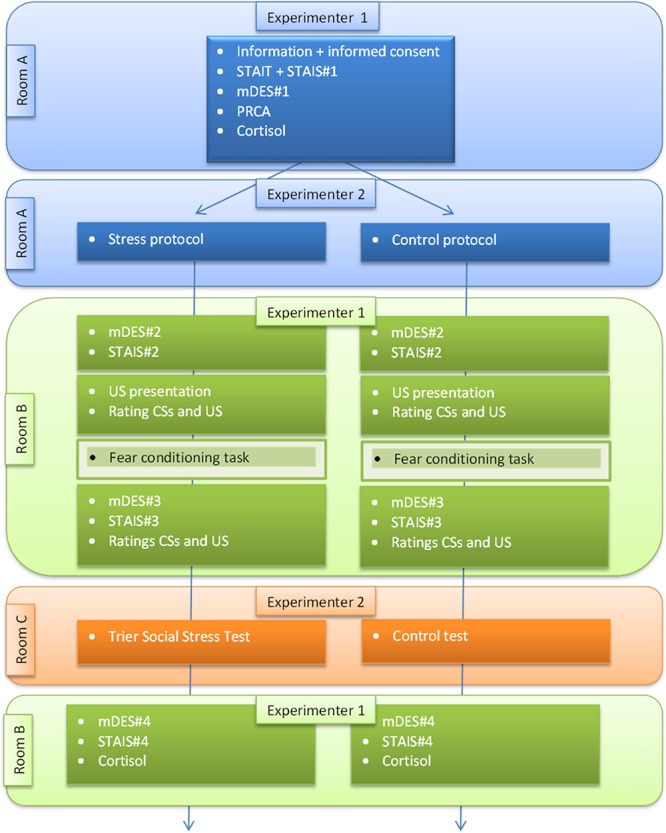
Note that different colors represent different rooms.